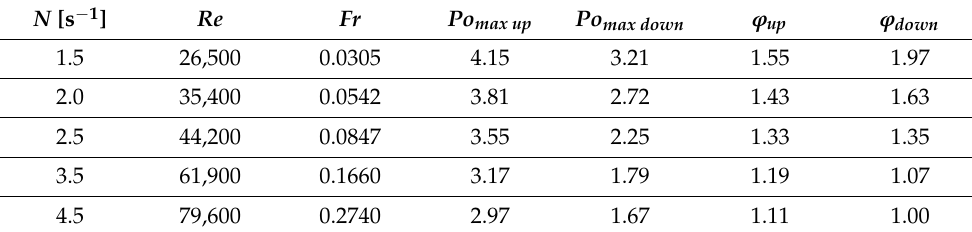
Table 2. Mixing power increase factors for reference value Po both = 2.67 and P down = 1.67 N [s − 1 ] Re Fr Po max up Po max down ϕ up ϕ